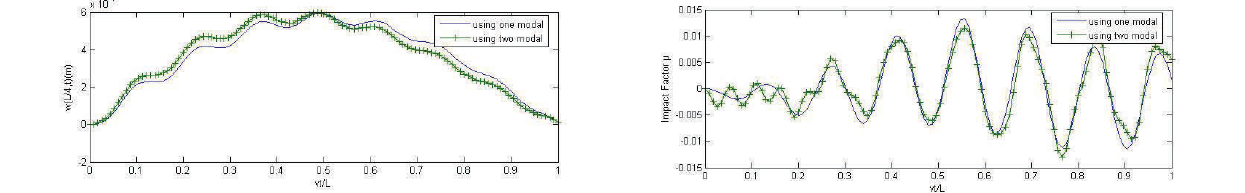
Figure 8. Impact factor with k=0.25 and v=20